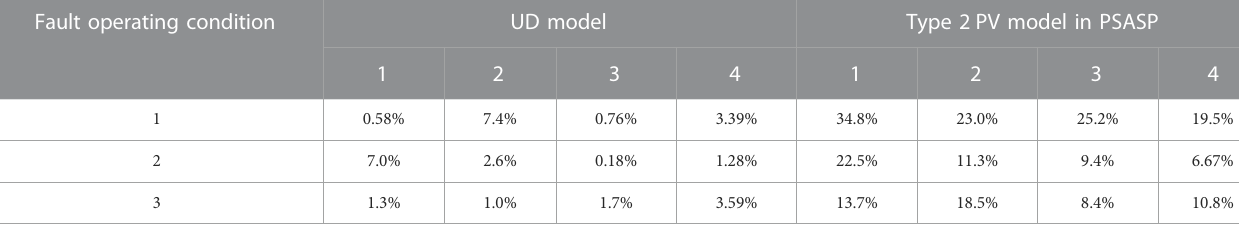
TABLE 3 Comparison of equivalent results using the UD model and type 2 PV